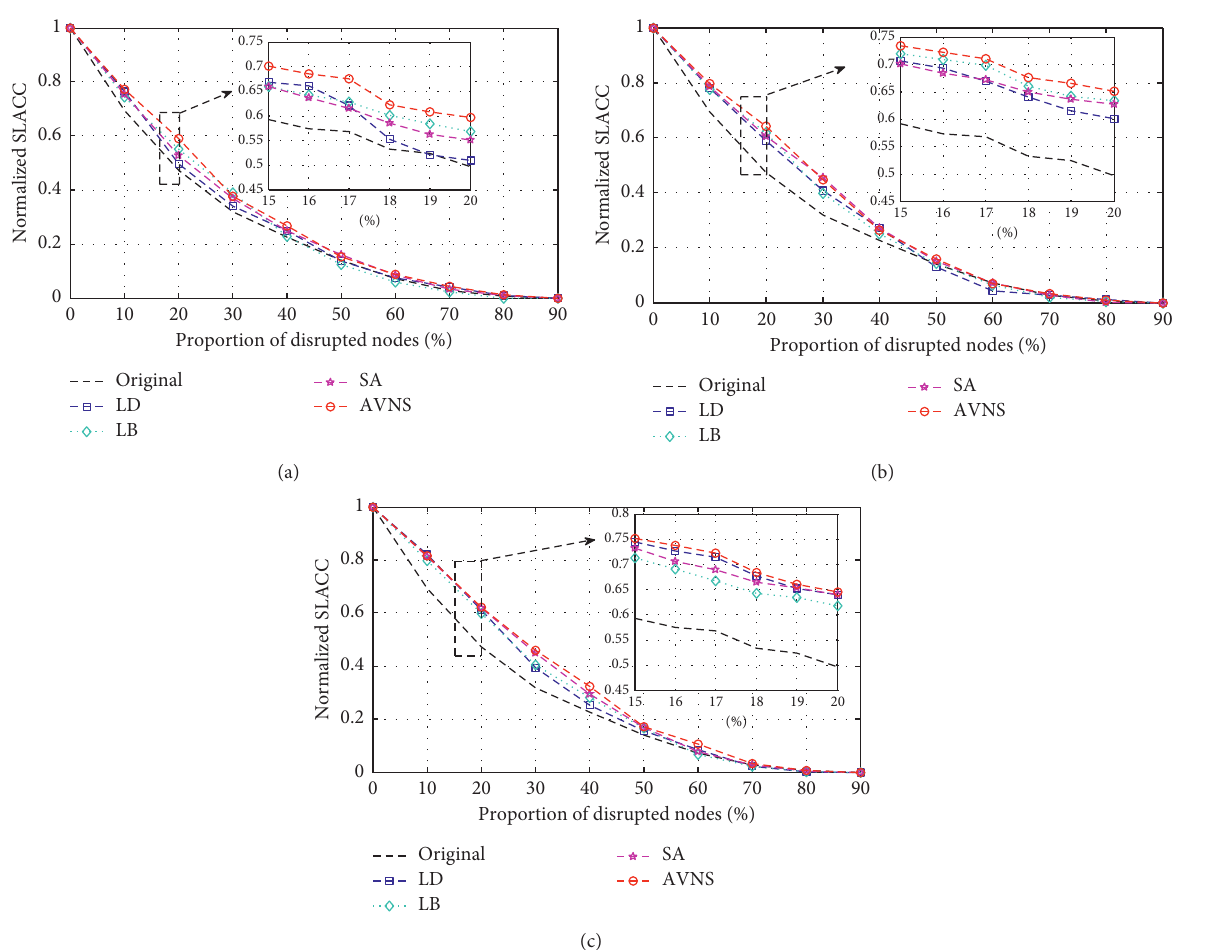
� 5%. (b) f � 10%. (c) f � 15%. a a a